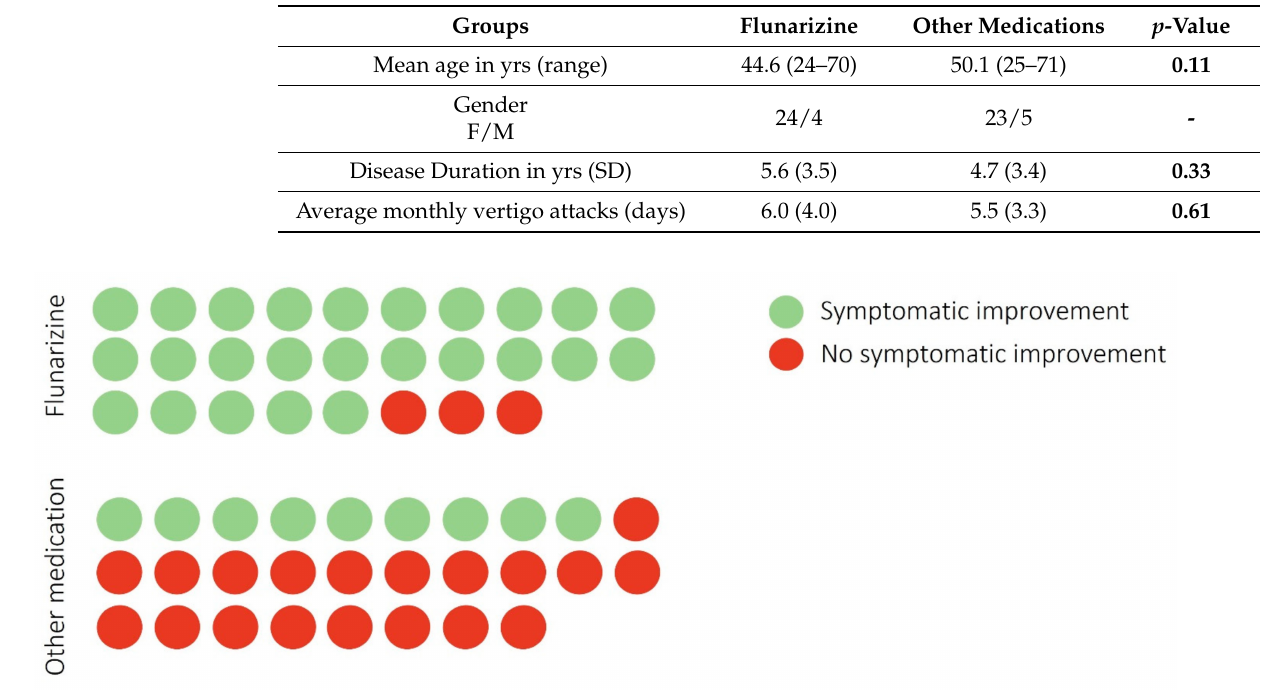
Table 1. Patient clinical and demographic data for Group 1 (Flunarizine) and Group 2 (‘Other medication’).